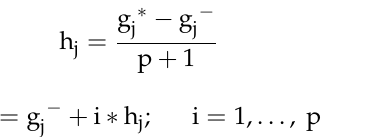
Figure 2 exposes the establishment of the class profiles obtained through the bh procedure: